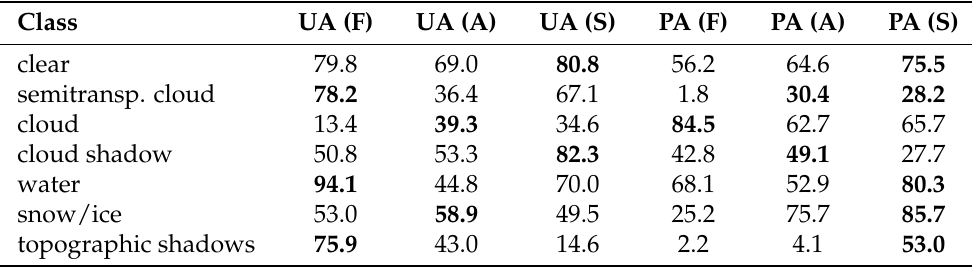
Table 4. Summary of classification accuracy (percent) for difference area (F = Fmask, A = ATCOR, S = Sen2Cor; bold face numbers indicate the best